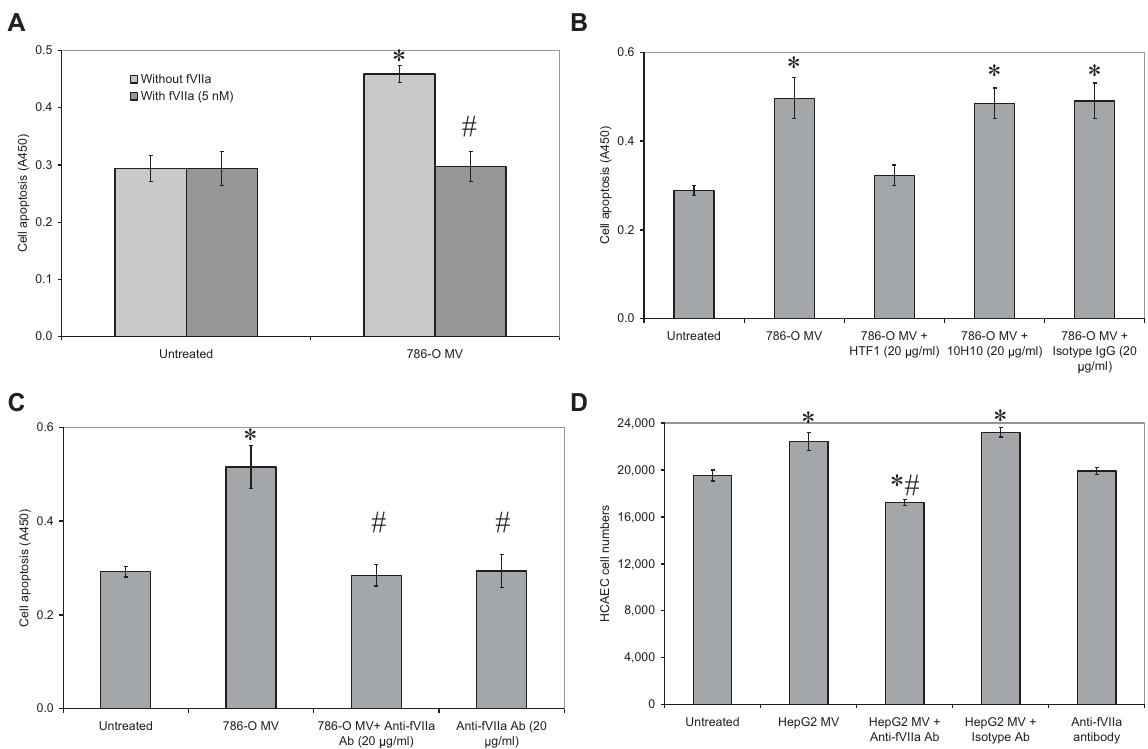
Fig. 6 Active fVIIa both attenuates and is required for the induction of HCAEC apoptosis by microvesicle-associated TF. ( A ) Sets of HCAEC (2 (cid:1) 10 4 ) were incubated with microvesicles derived from 786-O cells alone, or supplemented with fVIIa (5 nM) and cellular apoptosis was measured after 24 hours ( n ¼ 5; (cid:4) ¼ p < 0.05 vs. the untreated sample, # ¼ p < 0.05 vs. the respective sample without fVIIa). ( B ) Microvesicles derived from 786-O cells were preincubated with HTF-1 anti-TFantibody (20 µg/mL) to block fVIIa binding, 10H10 anti-TFantibody (20 µg/mL) to block TF signaling, or an isotype mouse antibody (20 µg/mL), and cellular apoptosis was measured after 24 hours ( n ¼ 5; (cid:4) ¼ p < 0.05 vs. the untreated sample). ( C ) Microvesicles derived from 786-O cells were preincubated with an inhibitory anti-fVIIa antibody (20 µg/mL) prior to addition to HCAEC (2 (cid:1) 10 4 ) and cellular apoptosis was measuredafter 24 hours ( n ¼ 5; (cid:4) ¼ p < 0.05 vs. the untreated sample, # ¼ p < 0.05 vs. sample with microvesicle alone). ( D ) Microvesicles derived from HepG2 cells were preincubated with an inhibitory anti-fVIIa antibody (20 µg/mL) prior to addition to HCAEC (2 (cid:1) 10 4 ). HCAEC numbers were determined after 24 hours using the crystal violet staining assay and the cell numbers calculated ( n ¼ 5; (cid:4) ¼ p < 0.05 vs. the untreated sample, # ¼ p < 0.05 vs. sample with microvesicle alone). HCAEC, human coronary artery endothelial cells; TF, tissue